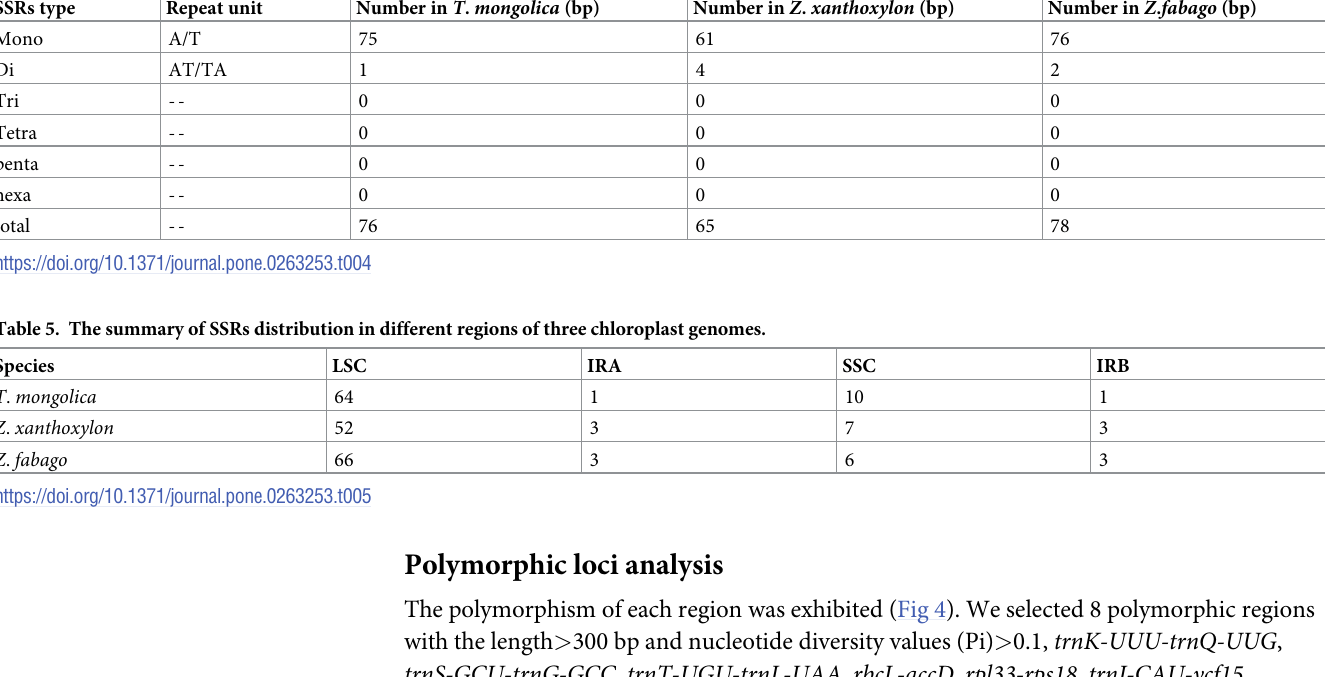
Table 4. Types and numbers of SSRs in chloroplast genomes of T . mongolica , Z . xanthoxylon and Z . fabago . SSRs type